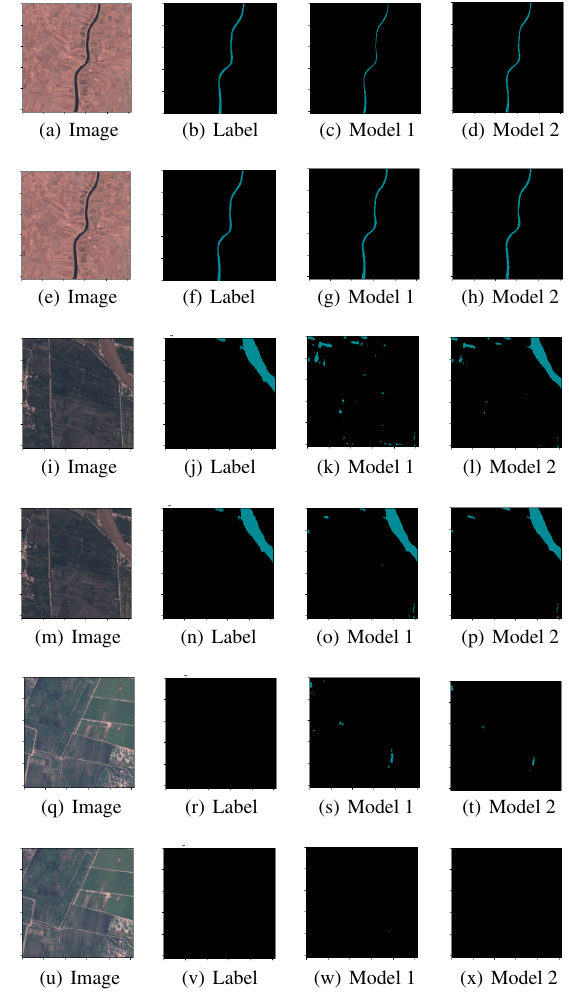
Figure 3. Example image patch (a), (e), (i), (m), (q), (u), ground-truth label (b), (f), (j), (n), (r), (v), the predictions when it has 68 training samples from model 1 (c),(k),(s) as well as of the model 2 (d),(l),(t), and the predictions when it has 680 training samples with the model 1 (g),(o),(w) as well as with the model 2